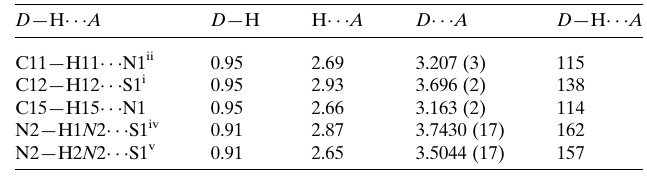
Table 1 Selected geometric parameters (A˚ , (cid:4) ).